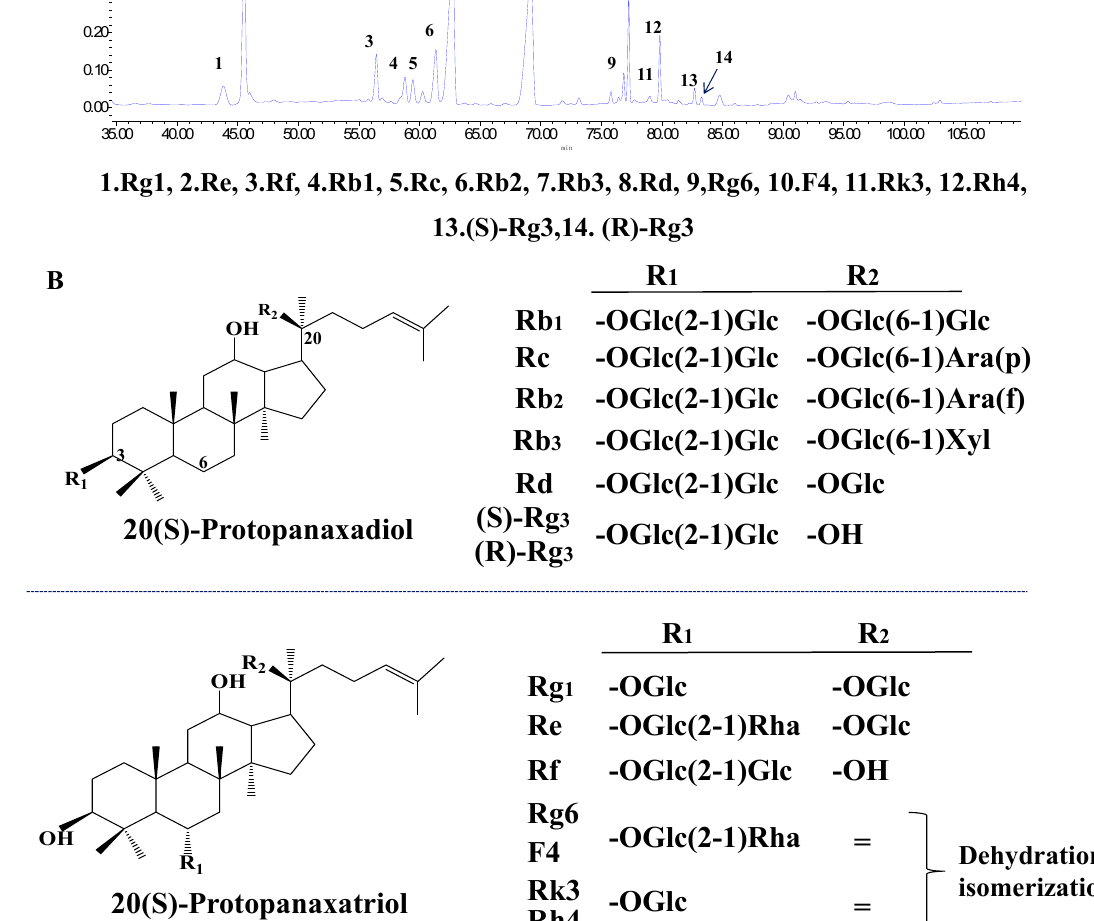
Figure 1. ( A ) Fourteen saponins from leaves of P. quinquefolius are confirmed by HPLC analysis, chromatograms and chemical structures of these saponins mainly includes panaxadiol-type ginsenosides Rb1, Rc, Rb2, Rb3; Rd, 20(S)-ginsenoside Rg3, 20(R)-ginsenoside Rg3 and panaxatriol-type ginsenosides Rg1, Re, Rf, Rg6, F4, Rk3, and Rh4. (B) The structures of these fourteen saponins.